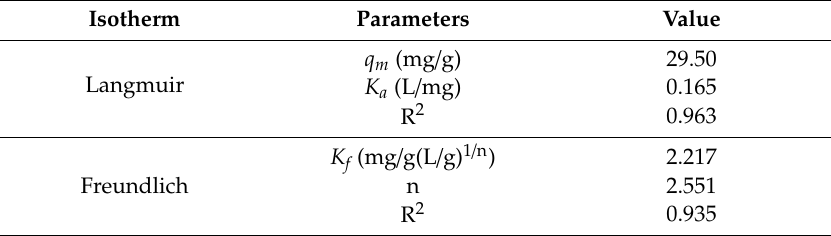
Table 5. Langmuir and Freundlich parameters of adsorption process at optimum